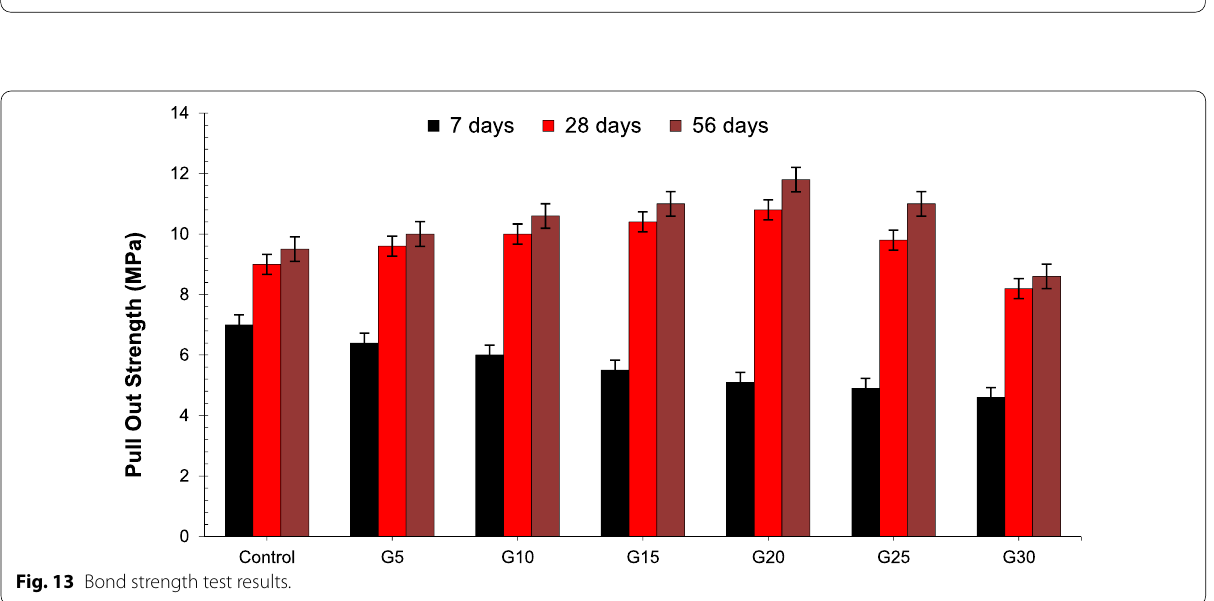
Fig. 12 Split tensile strength verses compressive strength.